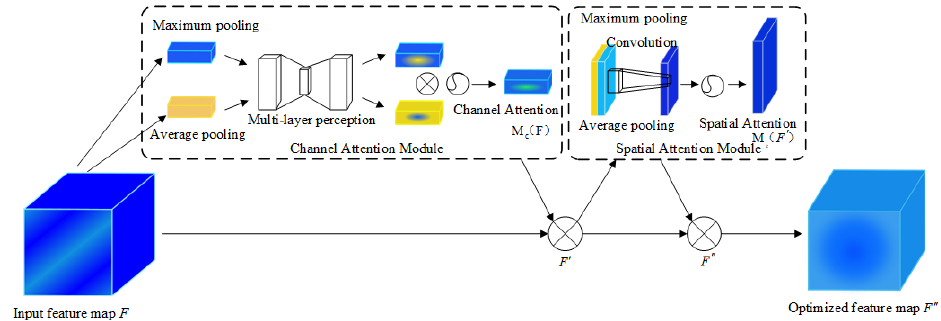
Figure 9. CBAM Attention Module.